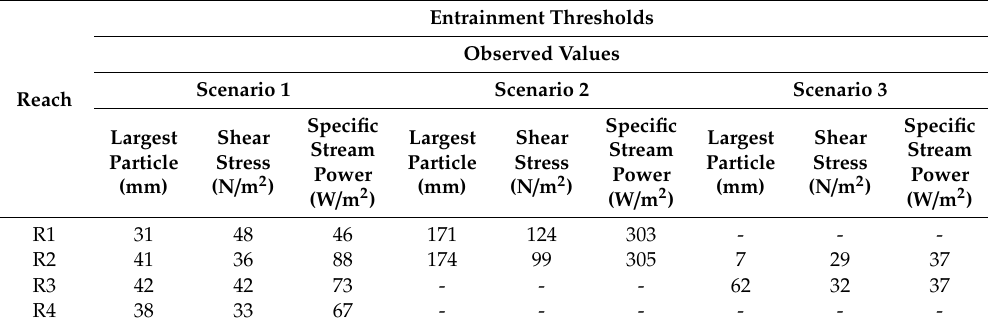
Table 3. Hydraulic estimations associated to largest particle mobilized for the di ff erent hydrological scenarios. Note that (i) mobility was measured just in R1 and R2 during scenario 2 (representative of the non-impacted and impacted reaches respectively), and that (ii) no mobility was observed in R4 during scenario 3.